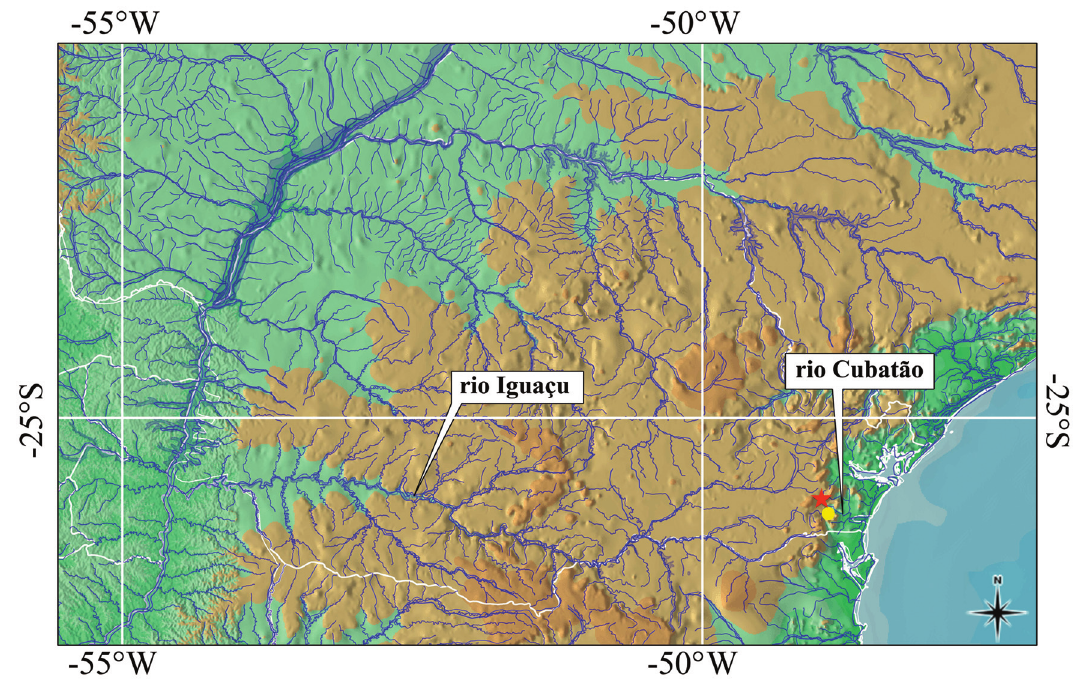
Fig. 3. Map of Paraná State and adjacent areas showing the distribution of Astyanax guaricana . The star represents the type locality (rio Arraial, at Reservoir of Guaricana dam, affluent of the rio Cubatão) and the circle represents the locality of the